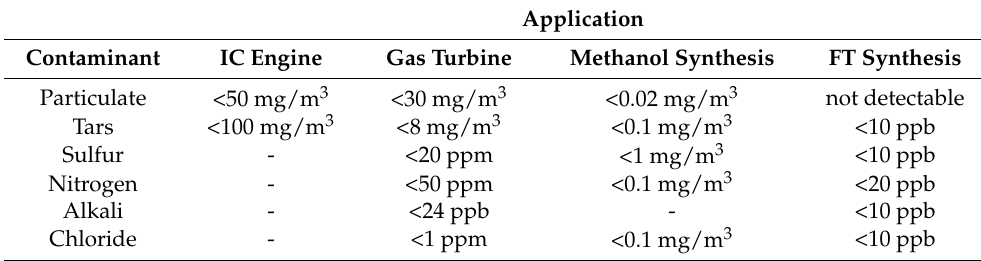
Table 2. Contaminant removal levels for various applications of producer gas. (Reprinted with permission from ref. [18]. Copyright 2014 Wiley Books.)